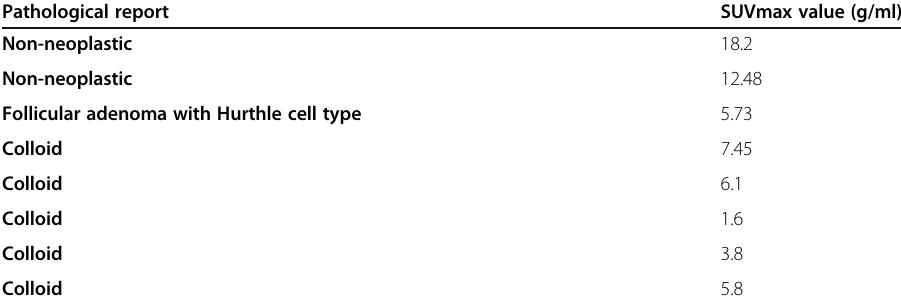
Table 2 The SUVmax values for the eight FNAC reported benign by the pathologist Pathological